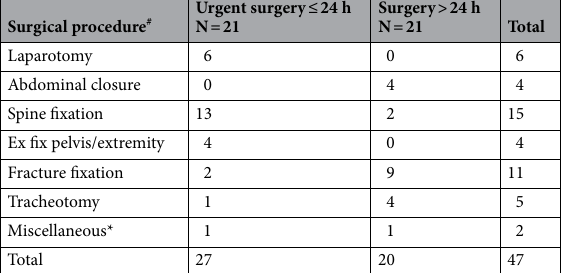
Table 3. Type and timing of surgery. # Several patients underwent more than 1 surgical procedure during 1 session in the operating room. *Miscellaneous surgeries included eye exploration, soft tissue debridement.